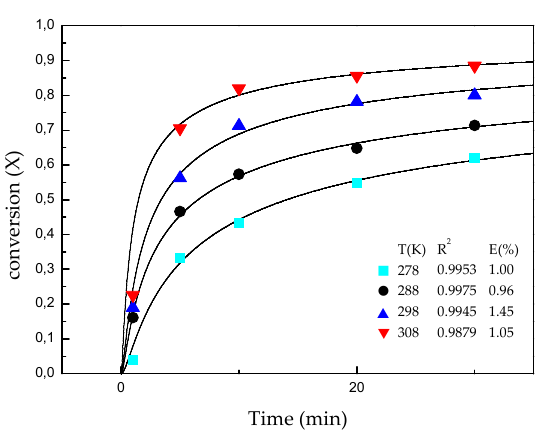
Figure 9. Correlation between experimental data and the proposed model.